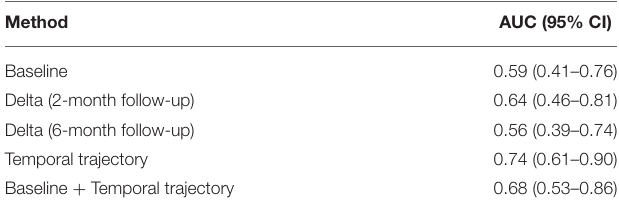
TABLE 2 | Significantly differing radiomics features between ORN and Control VOIs.